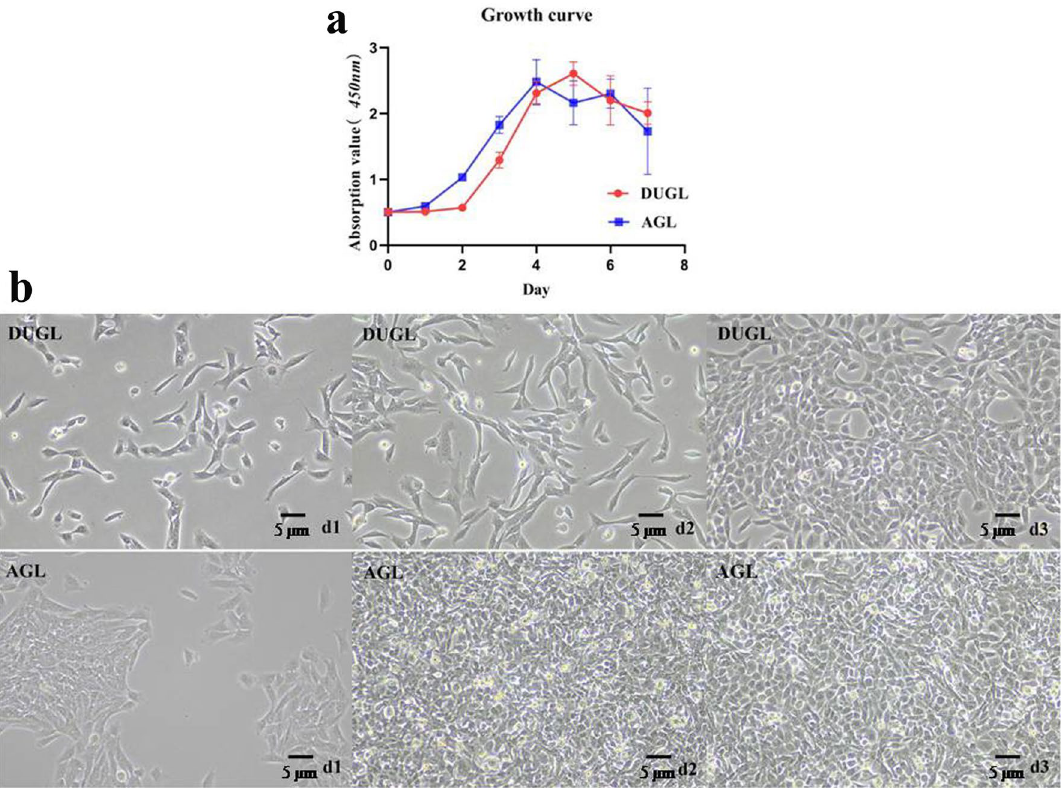
Figure 3. Growth curves of V79 cells cultured in the DUGL or AGL ( a ). V79 cells cultured for 3 days in the DUGL or AGL observed by light microscopy 10 × ( b ). AGL above-ground laboratory, DUGL deep underground